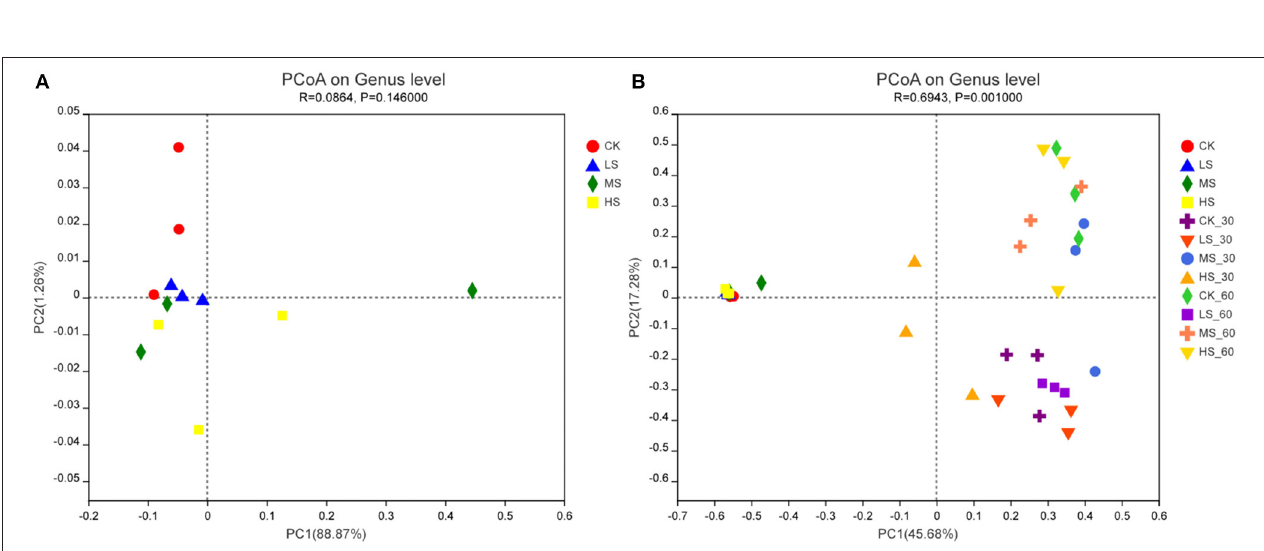
FIGURE 4 | Comparison of microbial variations using the Kruskal–Wallis H test for alfalfa silage. * p < 0.05. CK, fresh material of alfalfa without salt stress; LS, alfalfa under light salt stress; MS, alfalfa under moderate salt stress; HS, alfalfa under severe salt stress; 30, 30 days of ensiling; 60, 60 days of ensiling.